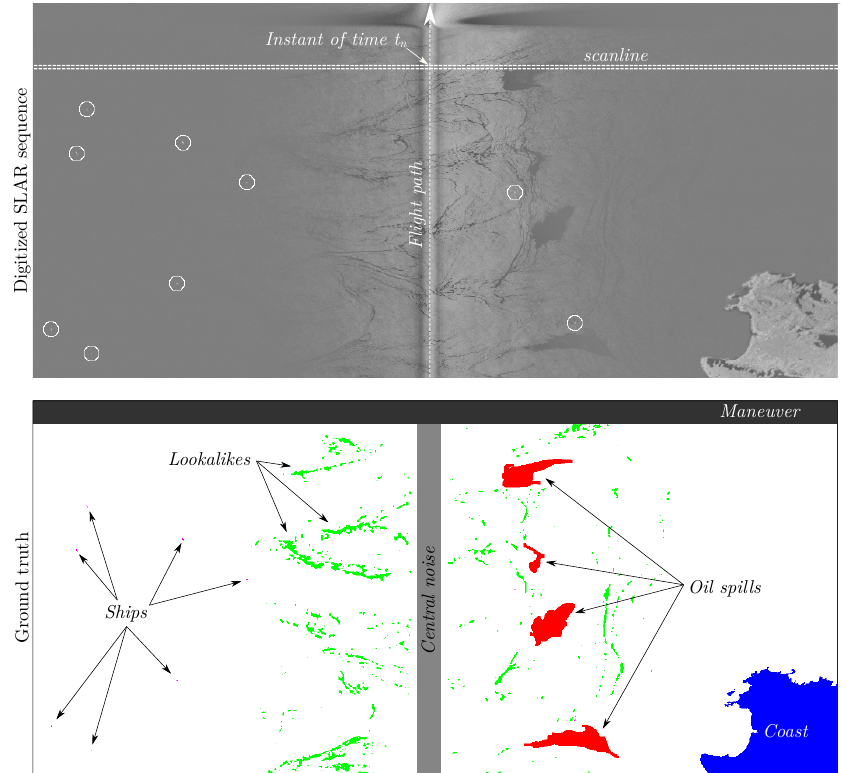
Figure 2. Representative image of a Side-Looking Airborne Radar (SLAR) sequence from our dataset ( top ) and its corresponding ground truth ( bottom ). Unlike in the previous work [27] in which only oil spills were labeled, in this ground-truth seven classes are labeled: Ships in fuchsia, oil spills in red, lookalikes in green, coast in blue, artifacts below the airplane in light gray, artifacts caused by its turns in dark gray, and water in white. Ships are marked with circles in the top image to help the reader to locate